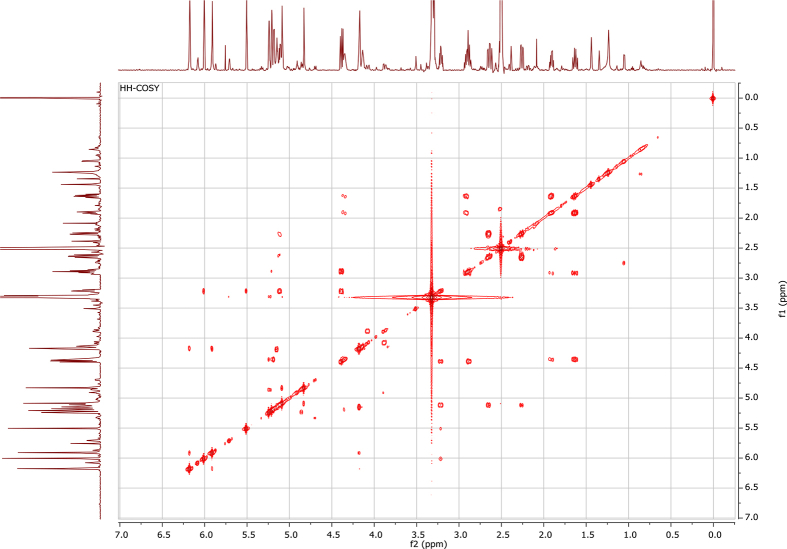
HH-COSY (DMSO-d6) spectrum of compound 12.